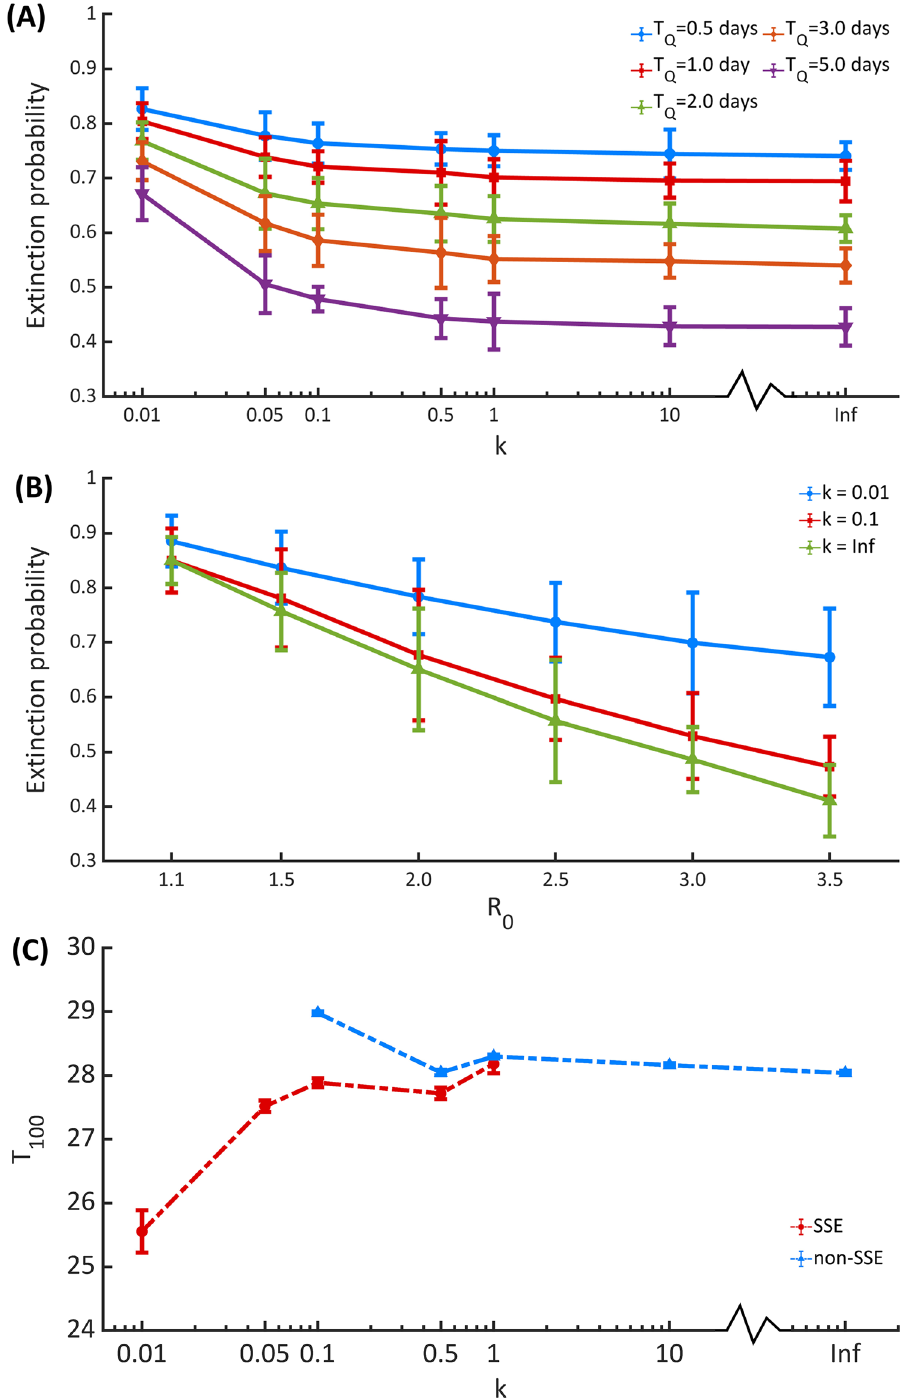
Figure 6. Impact of individual heterogeneity in infectiousness. The extinction probability of an outbreak with a different value of dispersion parameter k ( A ) and basic reproduction number R 0 ( B ). The first date at which the cumulative number of infected individuals exceeds 100 ( T 100 ) ( C ) The results are obtained from 100,000 simulations for each parameter set. Error bars show the 95%